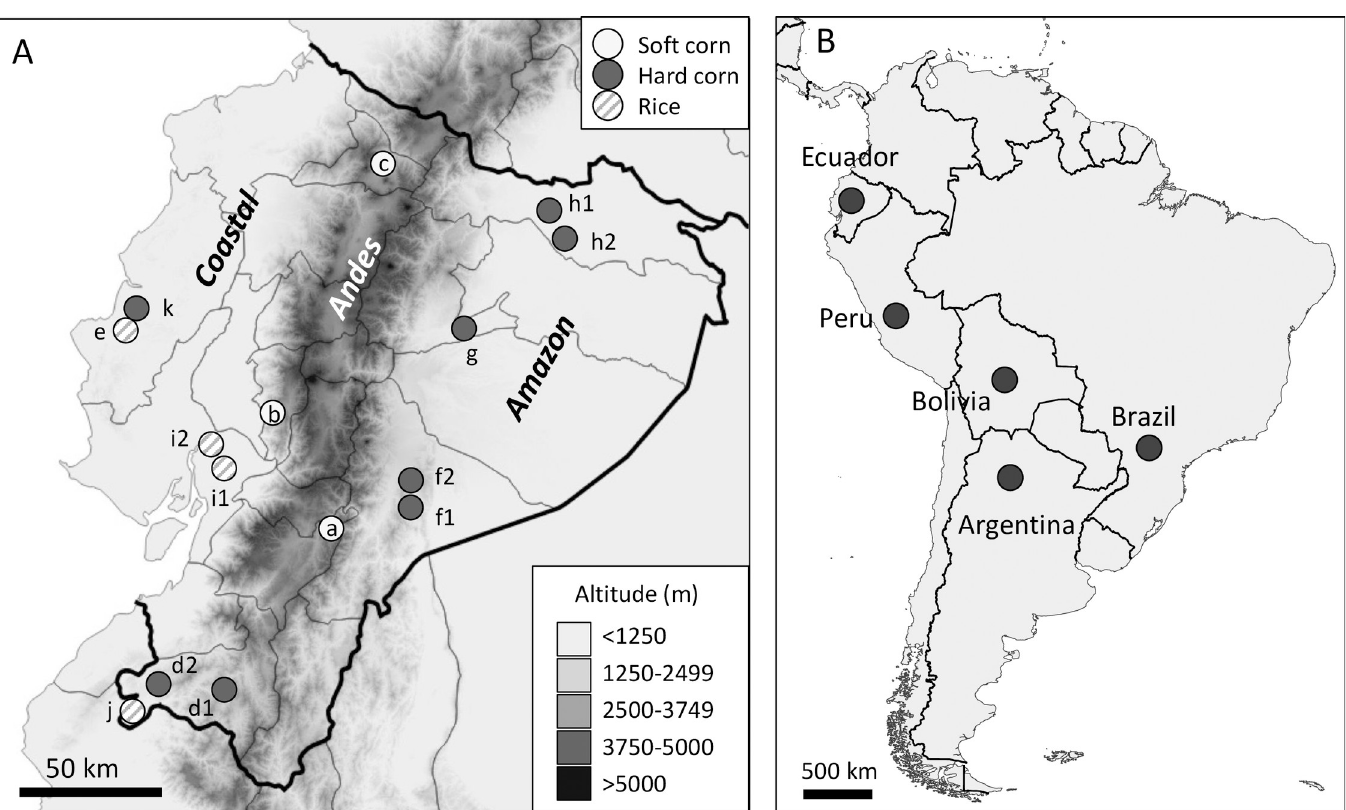
Fig 1. Maps showing locations of fall armyworm collection sites as described in Table 1. A: Map of Ecuador displaying outline of provinces and approximate locations of collection sites. The three major ecological regions (Coast, Andes, Amazon) are noted with differences in shading approximating elevation (meters above sea level). Circle patterns indicate the predominant host plant. Location letters refer to information from Table 1. B: Map of most of the northern half of South America showing locations of collection sites outside of Ecuador used in this study. The sites were in the vicinity of Lima (Peru), Mount Hope (Trinidad-Tobago), and Cotoca (Bolivia). Multiple provinces/states were surveyed in Brazil and Argentina with the most northern locations, Campo Verde (Brazil) and Salta (Argentina), identified on the map.